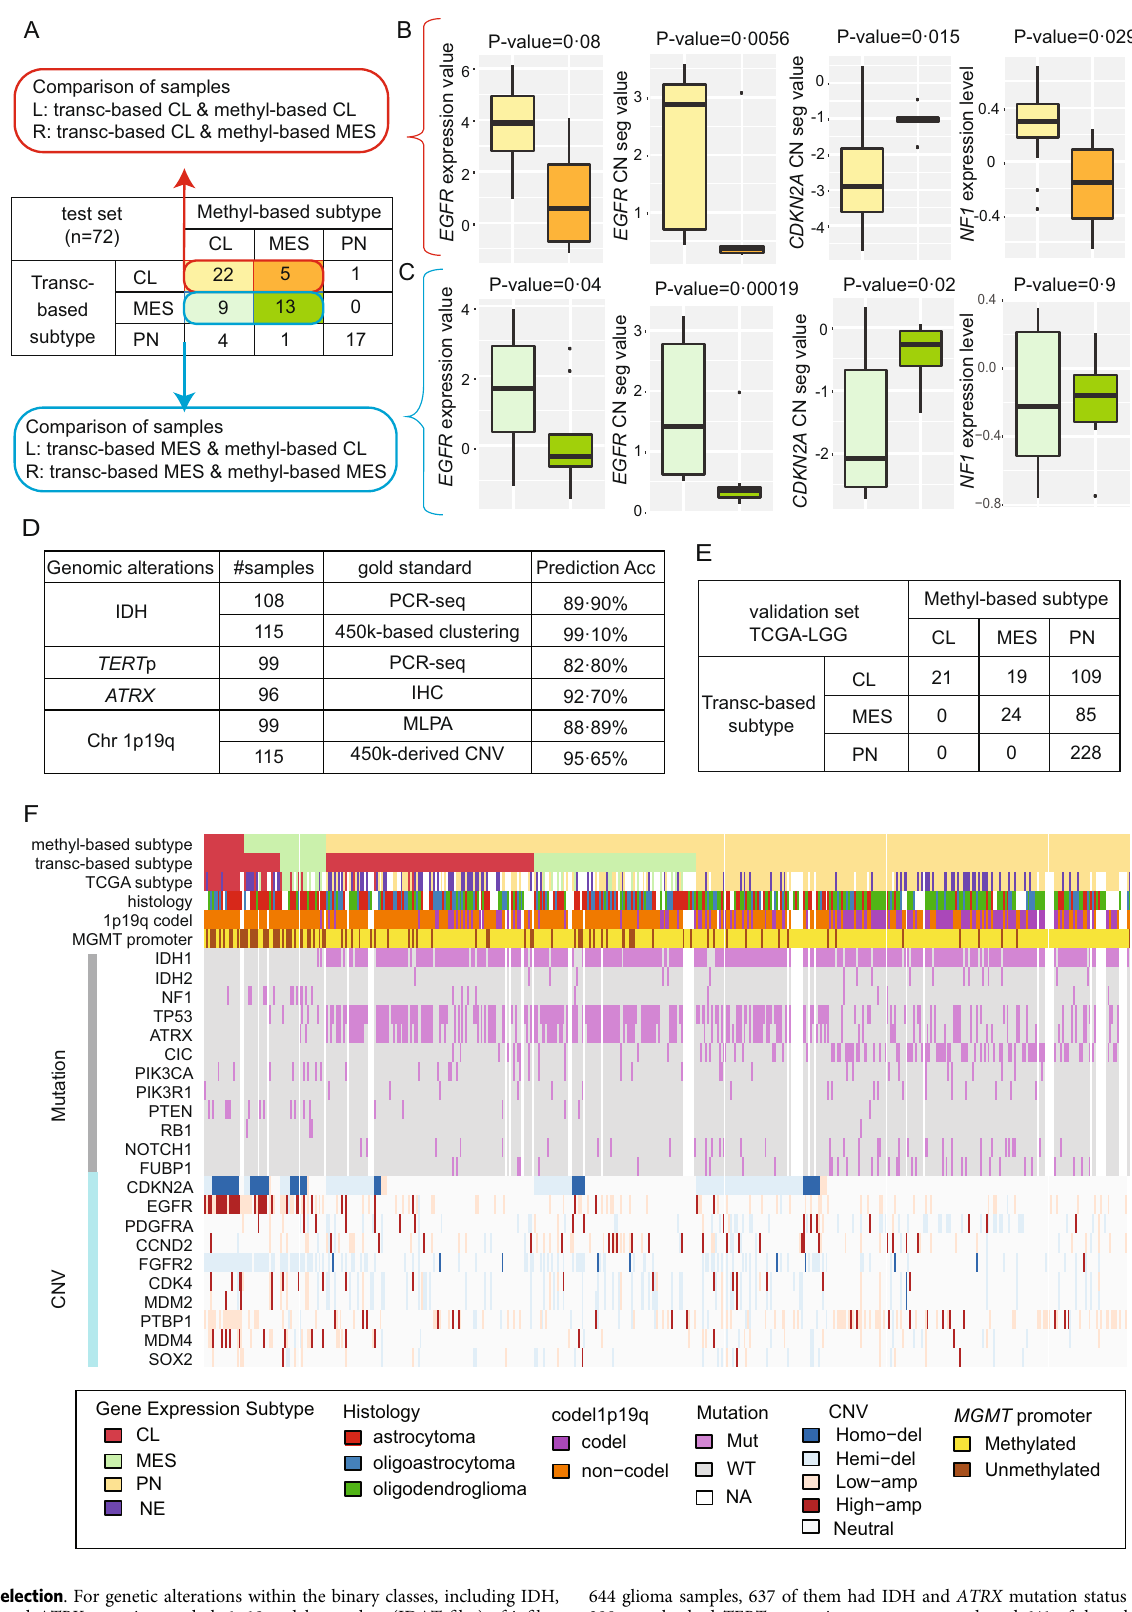
644 glioma samples, 637 of them had IDH and ATRX mutation status available, 298 samples had TERT p mutation status annotated, and 641 of them had chro- mosome 1p/19q co-deletion status annotated. For all binary genomic alterations, including IDH, ATRX , and TERT p mutations, and chr1p19q codel, the following fi lters were applied to the probes available in the In fi nium HumanMethylation BeadChip 450 K (HM450K) array: (1) remove probes not mapped to the autosomal chromosomes; (2) remove